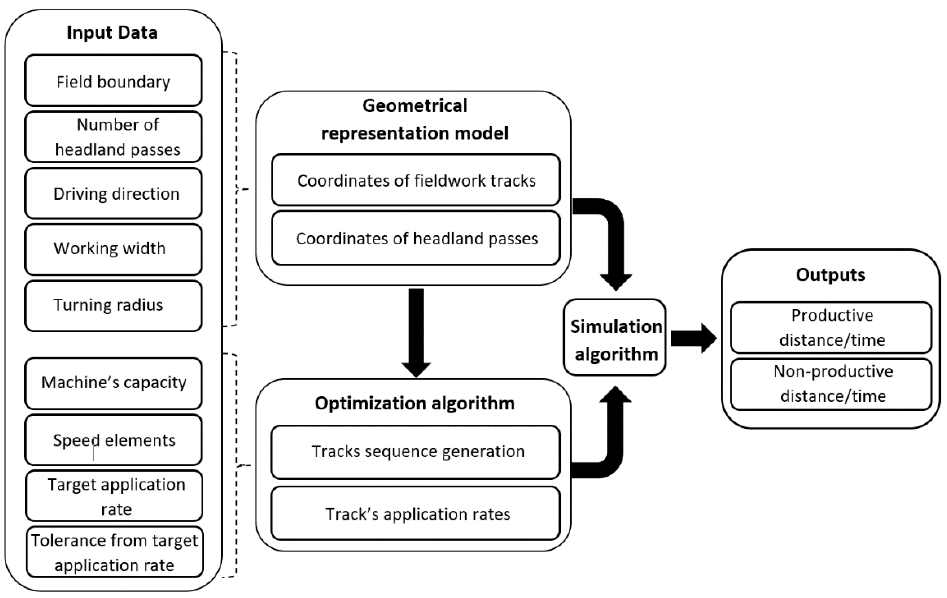
Figure 6. The overview of the simulation model.